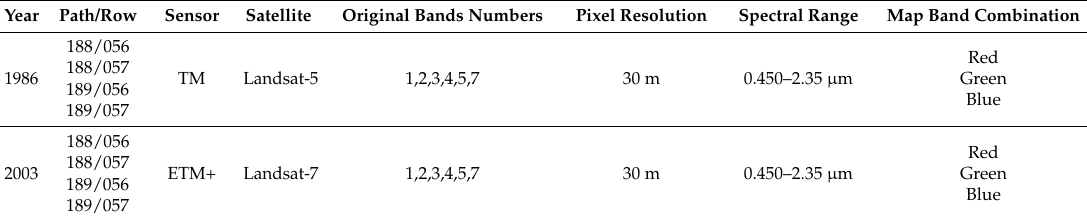
Table 1. Metadata of satellite images used in this research. Source: United States Geological